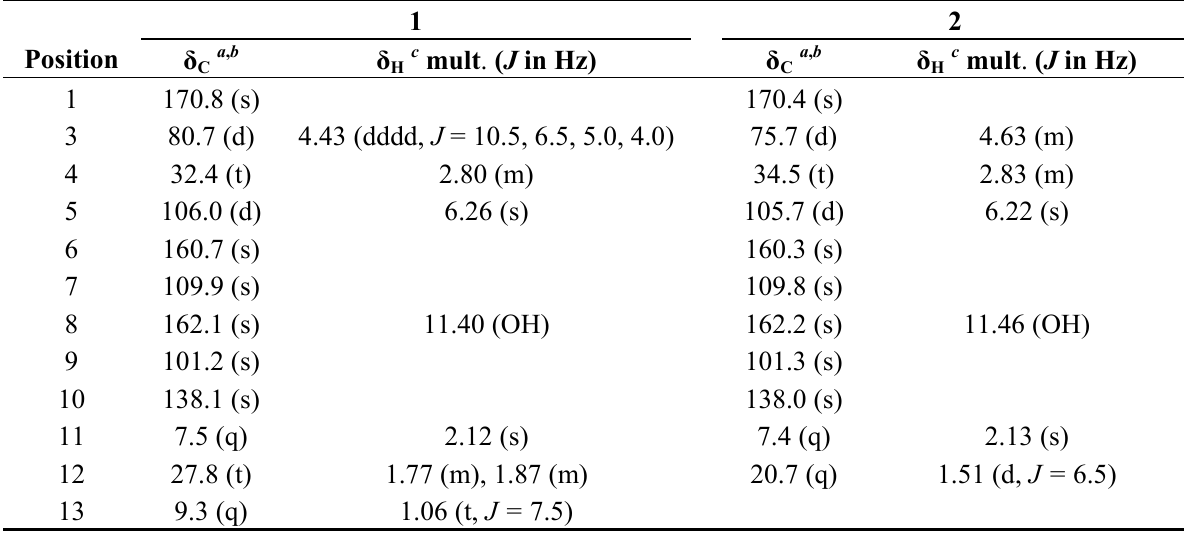
Table 2. NMR Data (500 MHz) for compounds 1 and 2 in CDCl